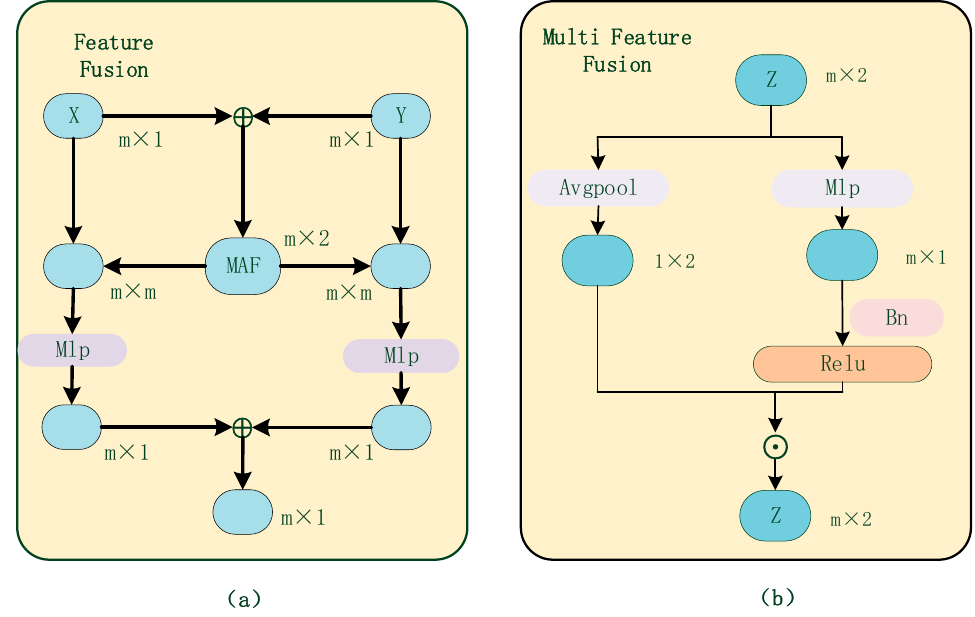
Figure 3. ( a ) is Feature fusion module. X and Y represent two input features, respectively. ( b ) is multi feature fusion (MFF). Z is the input data.